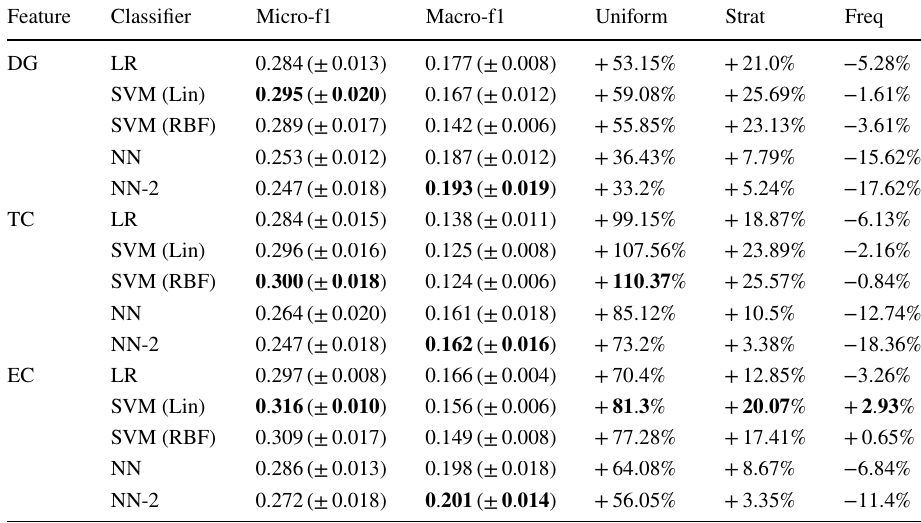
Bold values indicate the best for